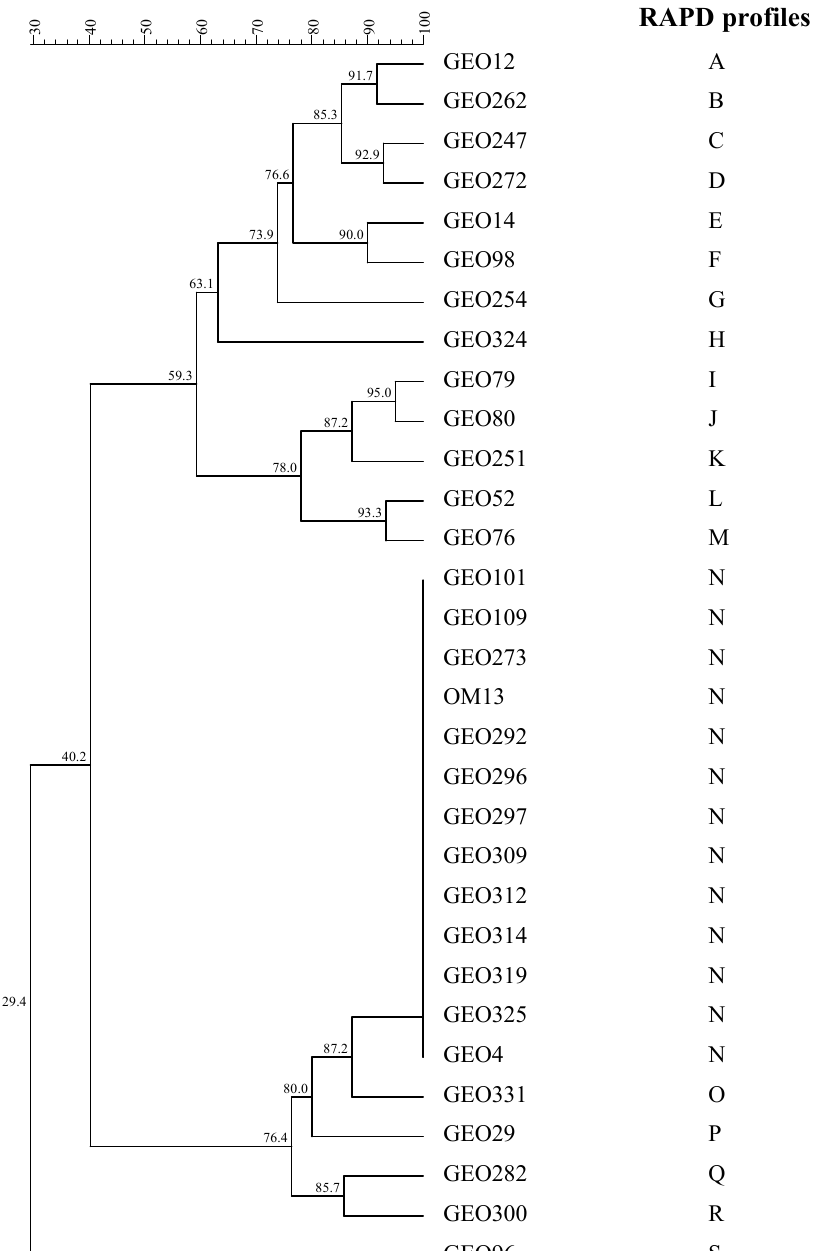
Figure 3. Dendrogram obtained from RAPD-PCR patterns of Lactiplantibacillus pentosus strains isolated from Nocellara del Belice table olive samples during fermentation.